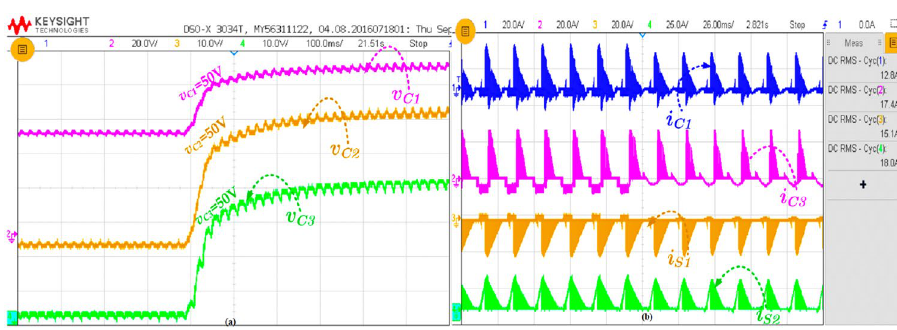
Figure 11. Experimental result of ( a ) capacitors voltages and ( b ) voltage and current of capacitors C 1 and switch S 1 .